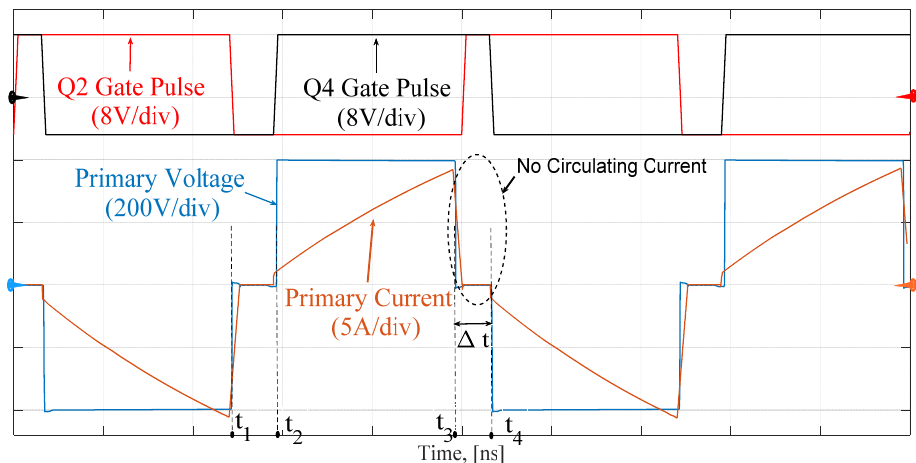
Figure 2. Main waveforms of the PSFB converter.